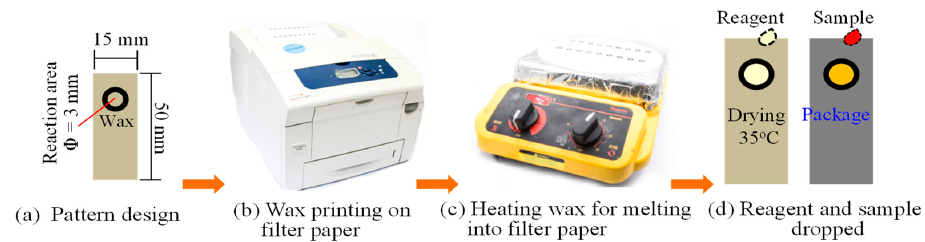
Figure 1. Schematic illustration showing main steps in fabrication procedure for paper-based chip.